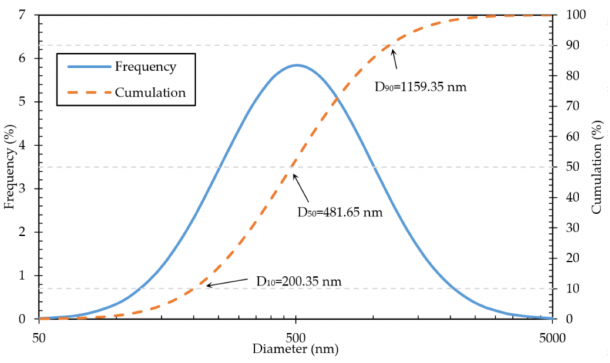
Figure 3. The Gaussian fit of laser size analysis of TPCB.